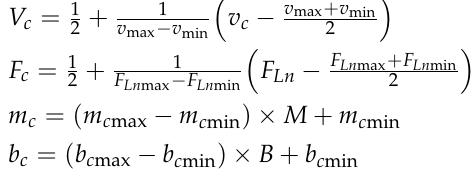
Table 1. Fuzzy rules of desired mass M .